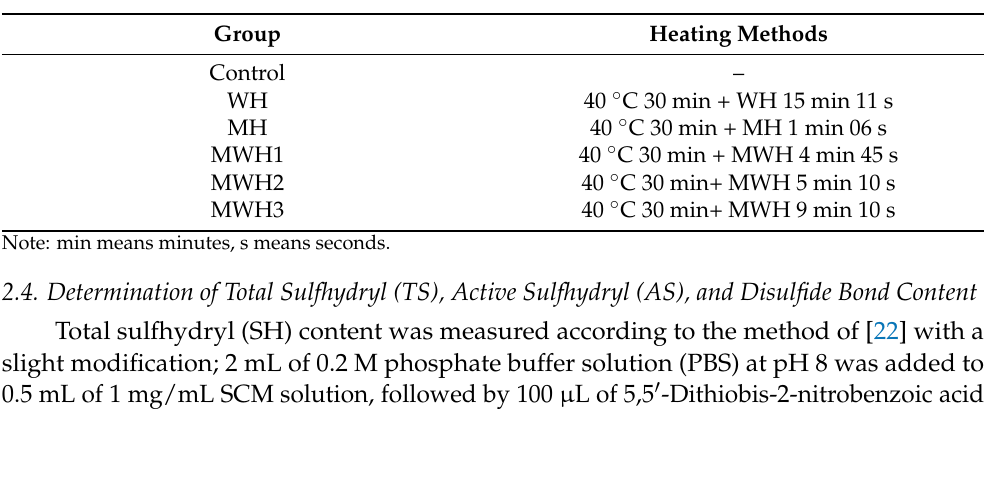
Table 1. Different heating methods of